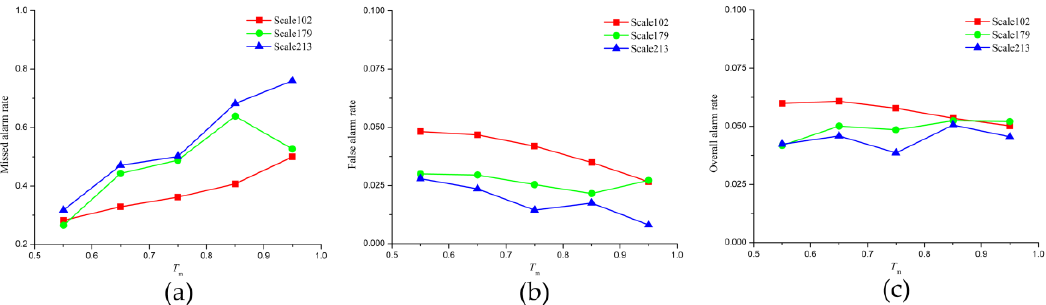
Figure 19. The influence of the uncertainty index threshold for DS1. ( a ) Missed alarm rate at various scales; ( b ) False alarm rate at various scales; ( c ) Overall alarm rate at various scales.